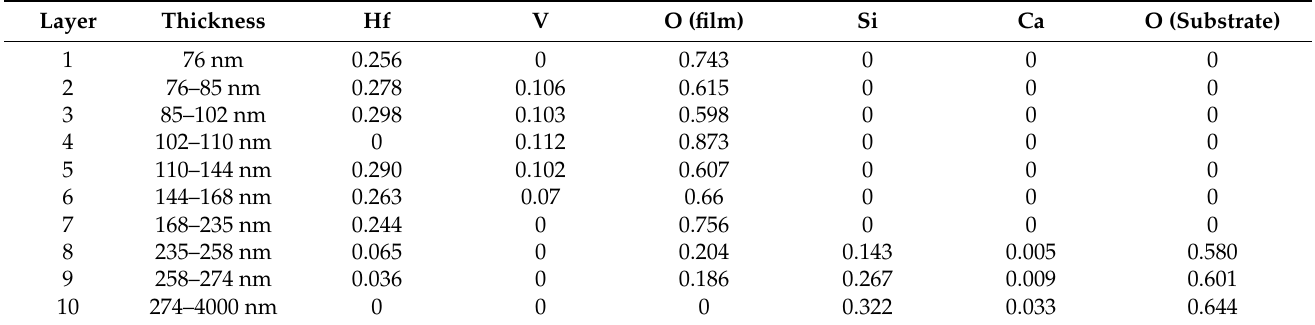
Table 2. In-depth profiling of a 400 ◦ C annealed sample’s thickness and its elemental